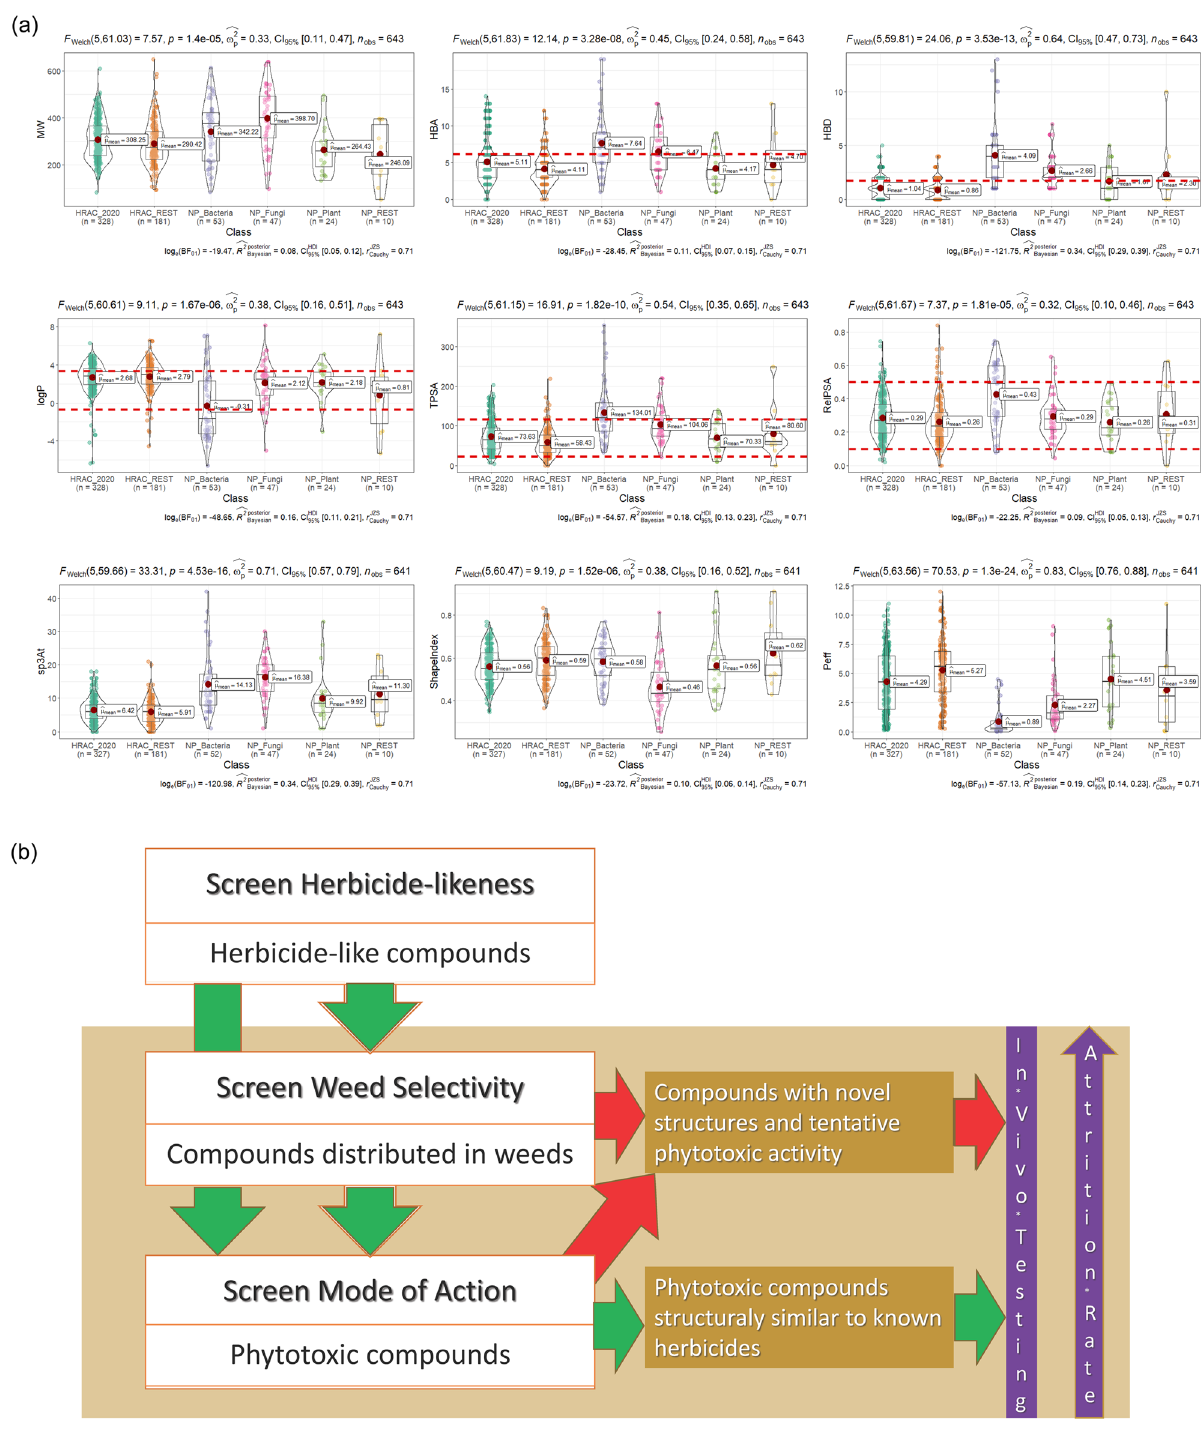
Figure 5. ( a ) The comparison of six subgroups of phytotoxic molecules according to selected molecular properties. Herbicide-like boundaries (Table 4) are denoted by red dash lines. ( b ) Virtual screening platform proposed for preselecting phytotoxic compounds. Its proof-of-concept should be carried out by in vivo